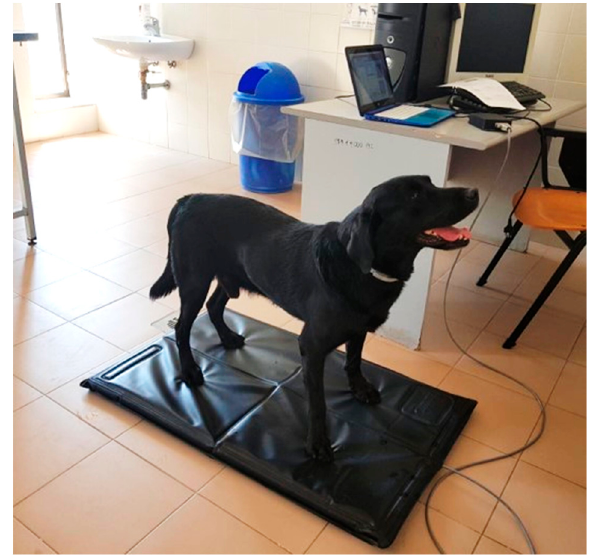
Figure 1. The Pet Safe Stance Analyzer. A Labrador Retriever affected by cranial cruciate ligament undergoing baropodometric evaluation standing on a padded platform. Data are elaborated by dedicated software on the main server.